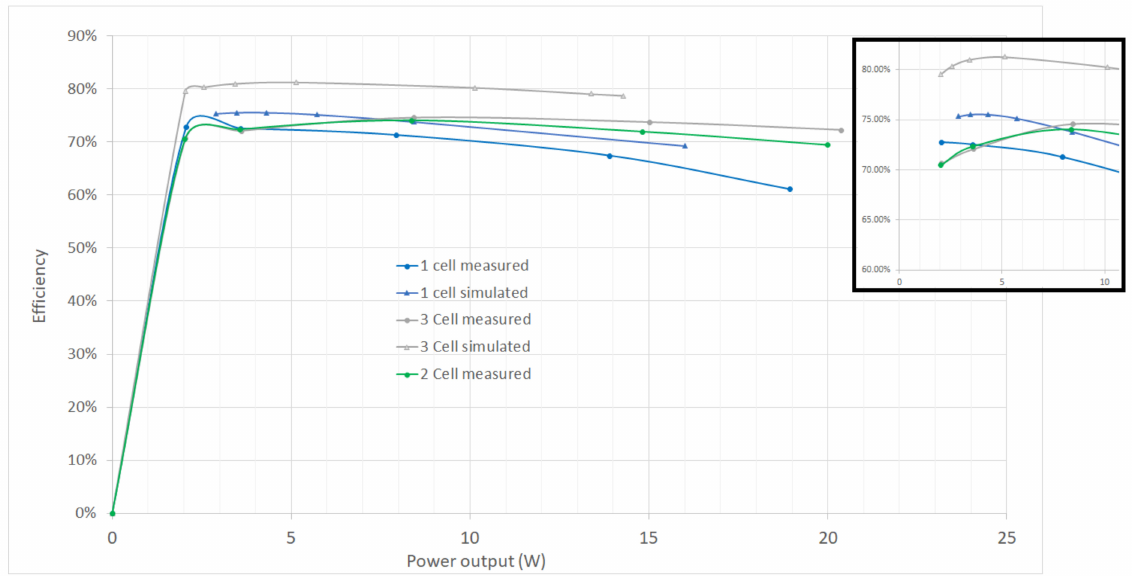
Figure 7. Efficiency comparison of 1-cell and 3-cell multicell buck